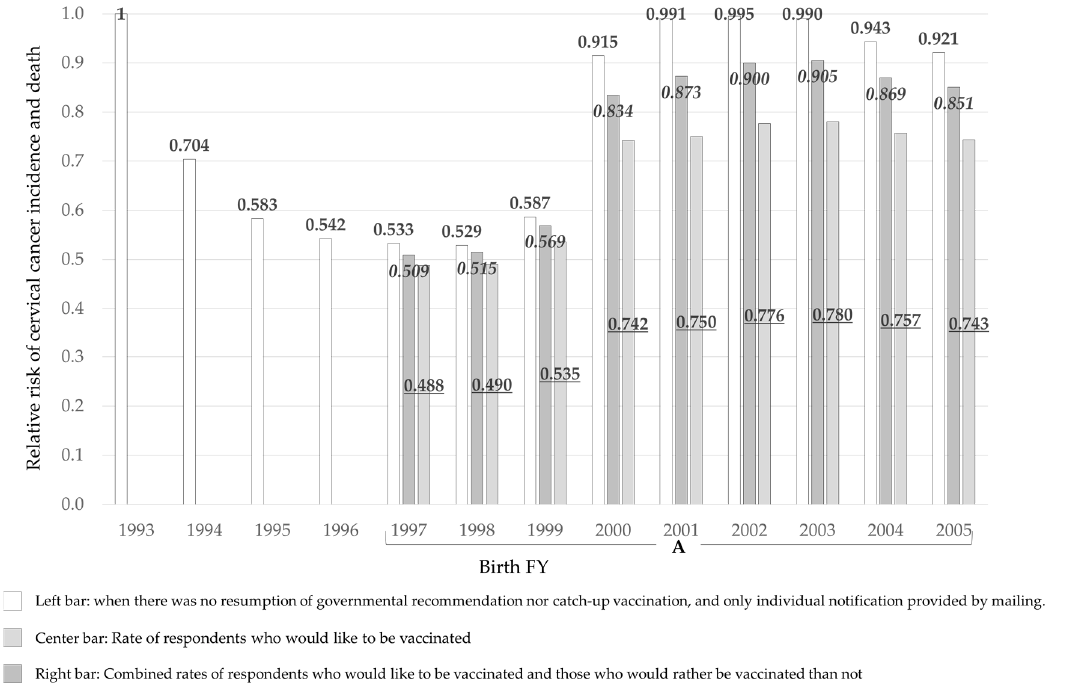
Figure 3. Risks estimated by substituting the vaccination intention obtained from the internet survey as the vaccination rate. A. Targets for catch-up vaccination targets FY2022 to 2024. 3.8. Estimated Number of HPV Vaccine Doses Required, Based on HPV Vaccination Intentions